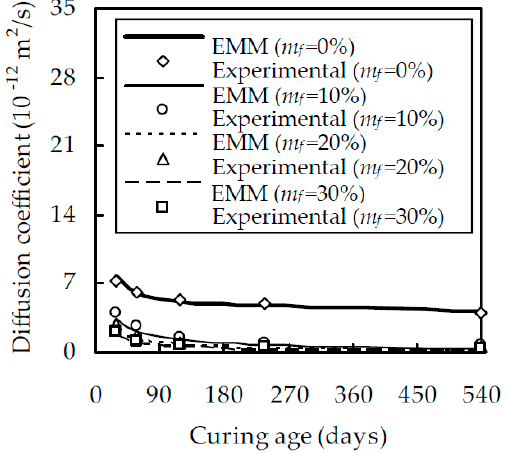
Figure 4. Relationship between D fc and t for fly ash cement paste with w/b of 0.4.